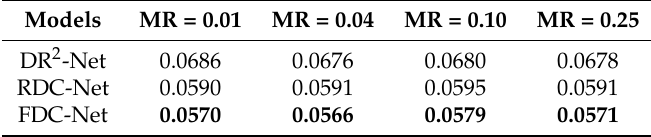
Table 5. Time (s) for reconstructing a single 512 × 512